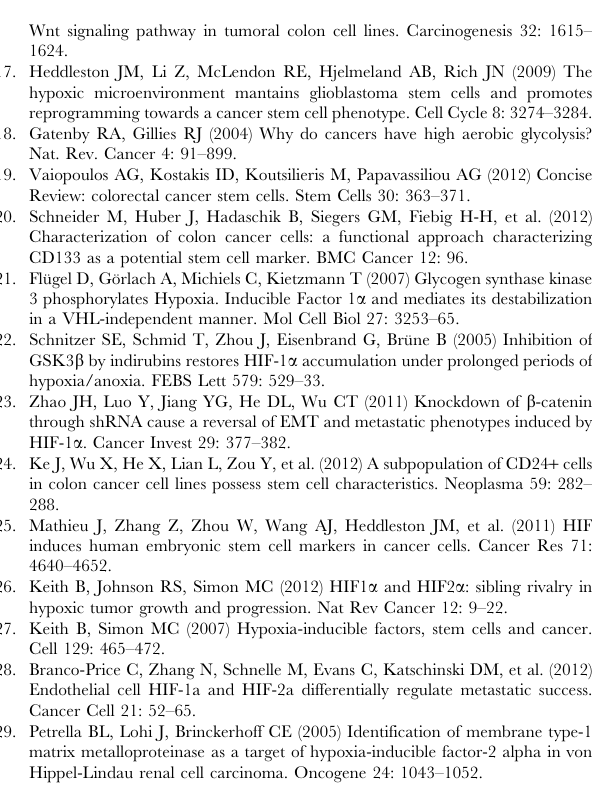
Figure S1 FACS analysis of HIF-1 a or HIF-2 a expression levels in SW480 cells cultured under normoxic or hypoxic conditions. Stable control (scrambled shRNA) or HIF-1 a - or HIF-2 a - silenced SW480 cells were incubated in the presence of EDTA, washed, and incubated with mouse anti-HIF- 1 a or anti-HIF-2 a . The cells were washed, stained with Alexa647- conjugated goat anti-mouse secondary antibody and examined by flow cytometry. The levels of HIF-1 a and HIF-2 a expression shown in bar graphs were estimated by normalizing to the corresponding expression levels observed in control cells. All of the assays were performed in triplicate, and the data represent the means 6 SEM from at least three independent assays. *: p , 0.05.